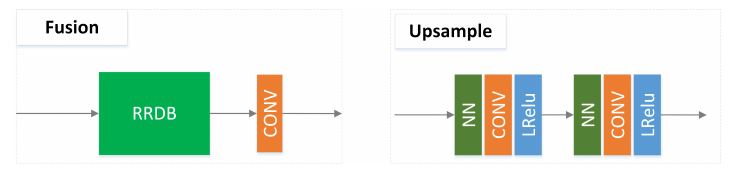
Figure 3. Fusion module and upsample module